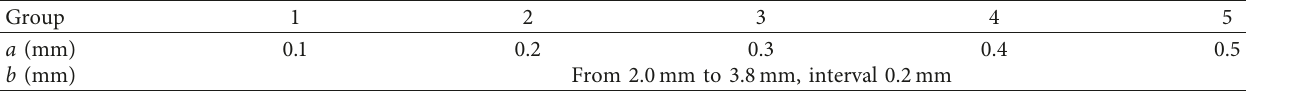
Table 1: Particle size for theoretical calculation.